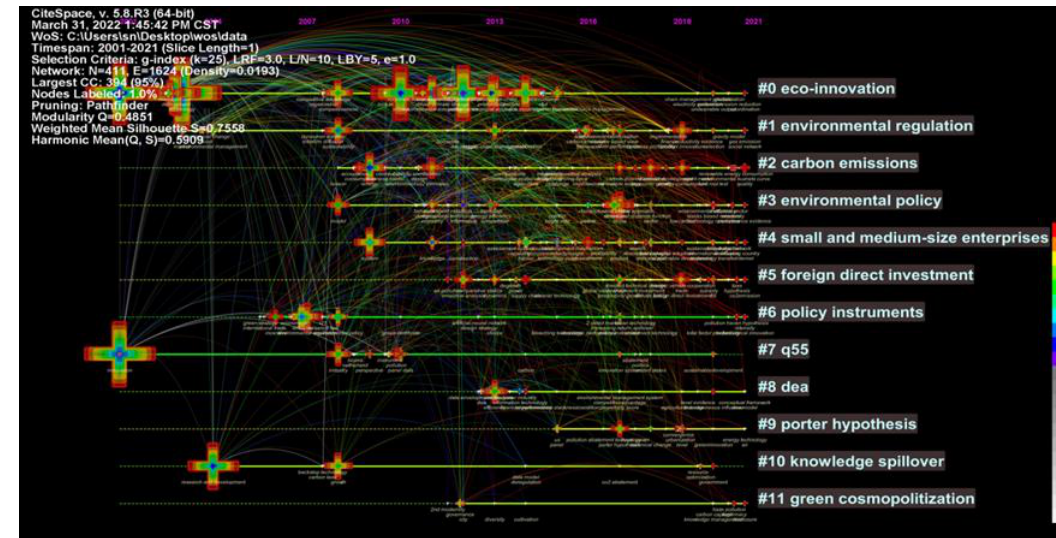
Figure 10. CiteSpace-based timeline mapping.